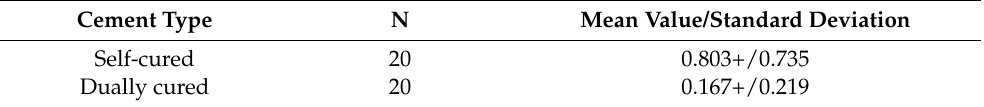
Table 3. Mean polymerization efficacy values and standard deviations of self-polymerizing and dual-polymerizing cements.